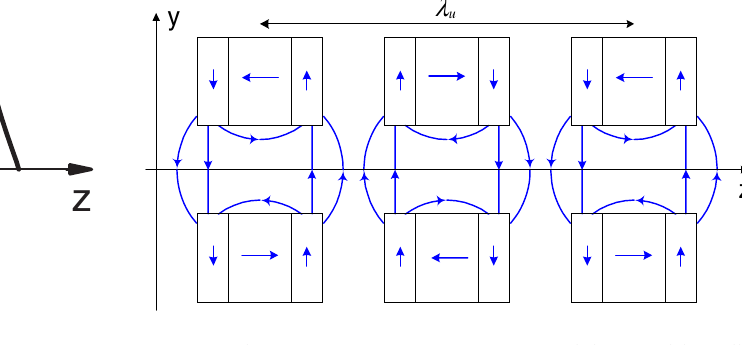
FIG. 4. The pure permanent magnet undulator with split ‘‘poles’’ (side view). Lines of magnetic induction are shown with